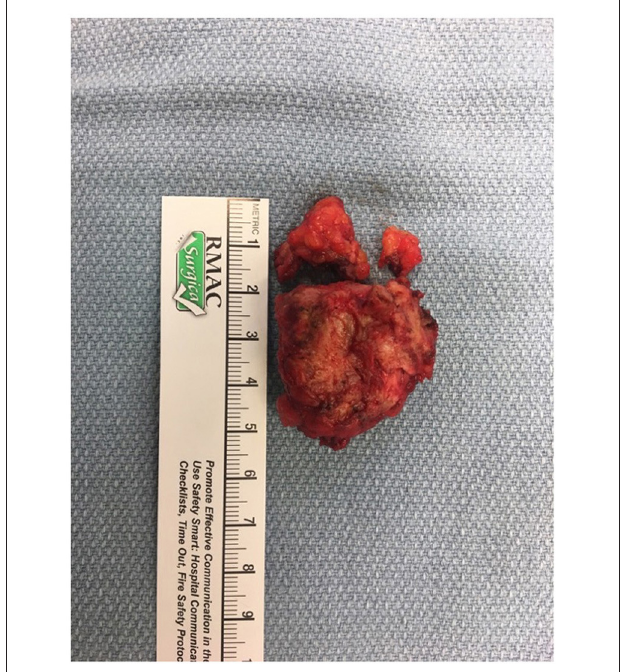
FIGURE 2 | Timeline of the episode of cares from initial pelvic trauma to most recent